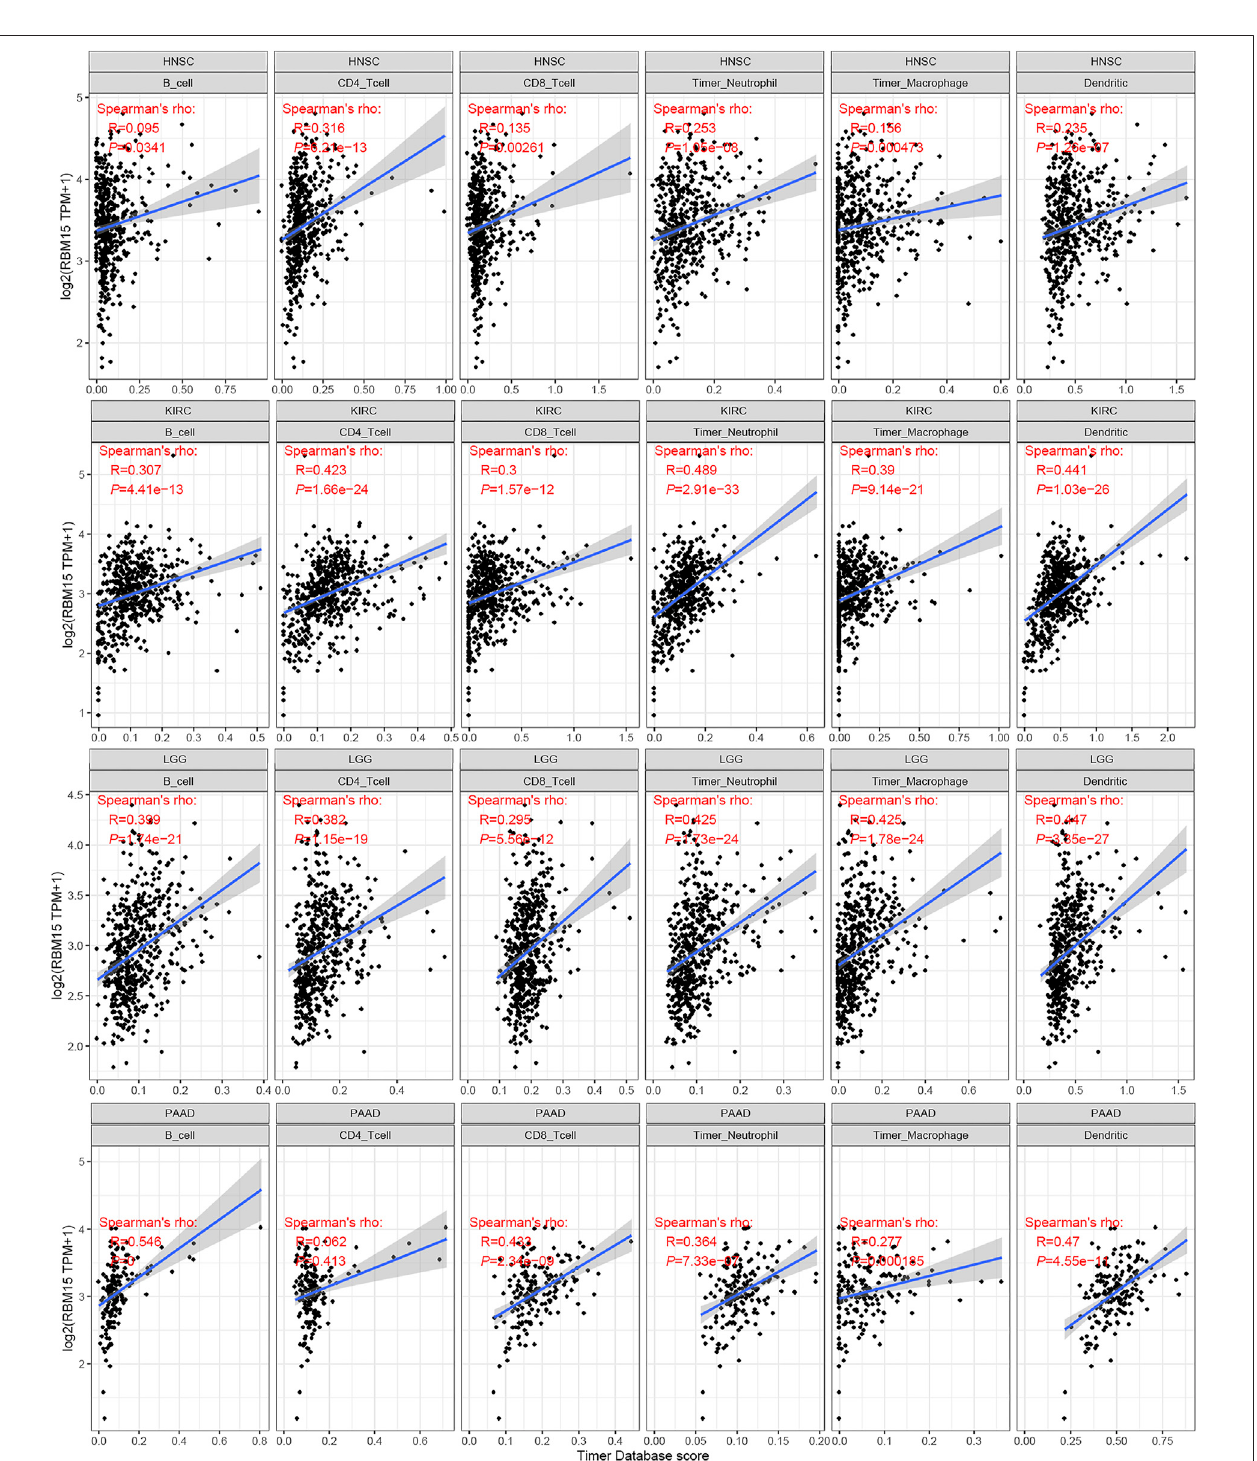
FIGURE 7 | Correlation of RBM15 expression with immune in fi ltration level of 6 types of immune cells in HNSC, KIRC, LGG, PAAD.